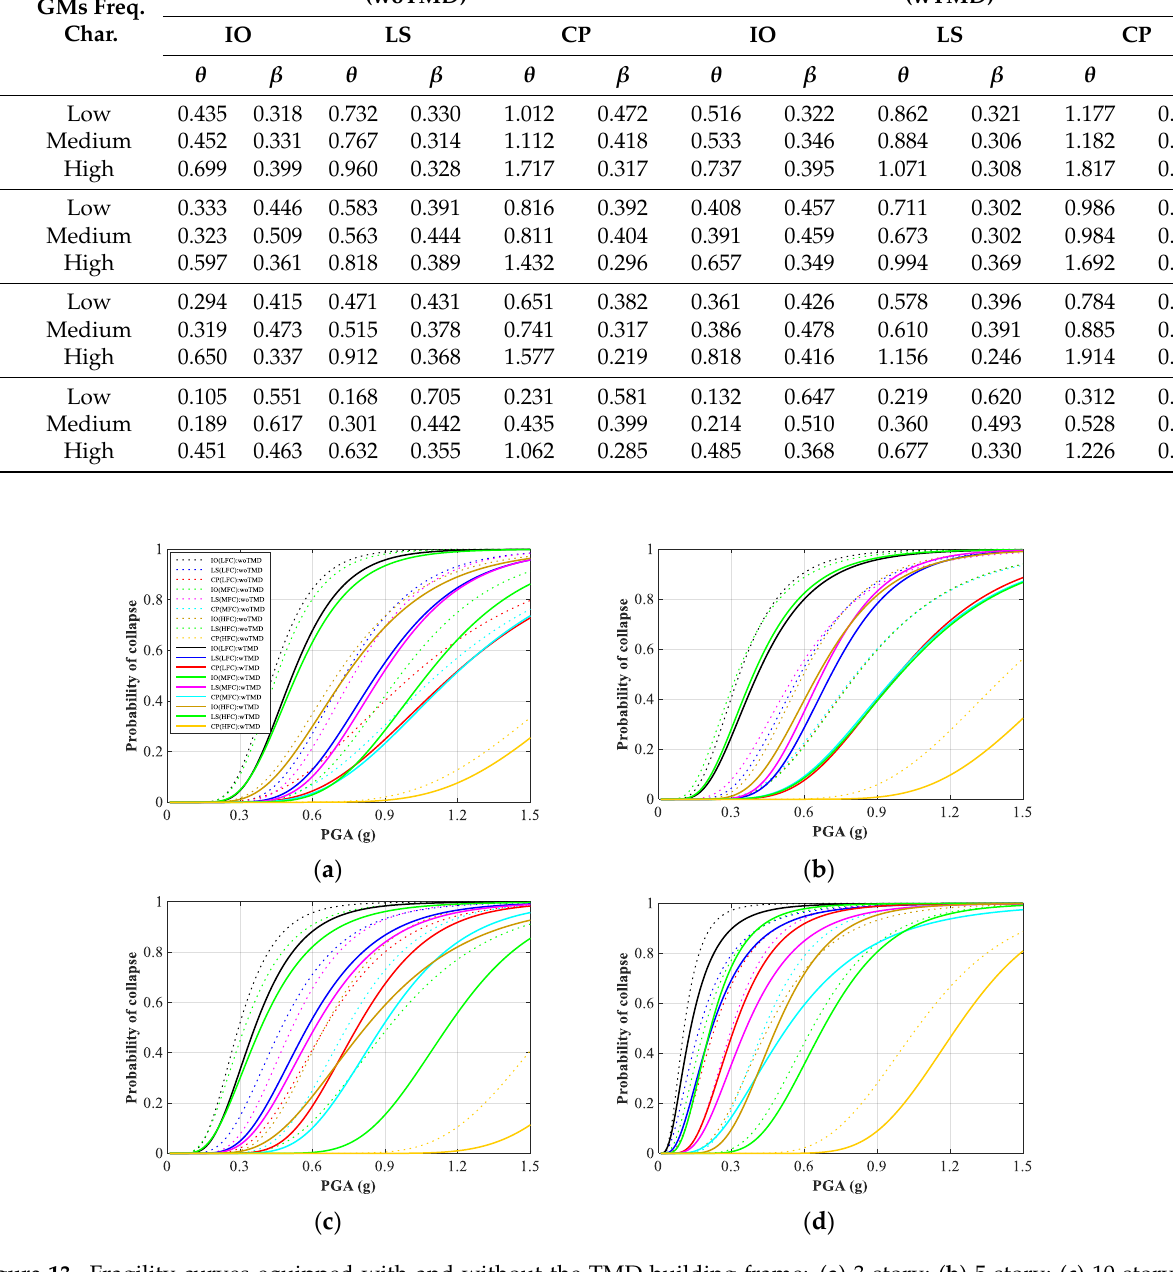
Figure 13. Fragility curves equipped with and without the TMD building frame: ( a ) 3 story; ( b ) 5 story; ( c ) 10 story; ( d ) 20 story. Table 4. Dynamic characteristics of the building frames.